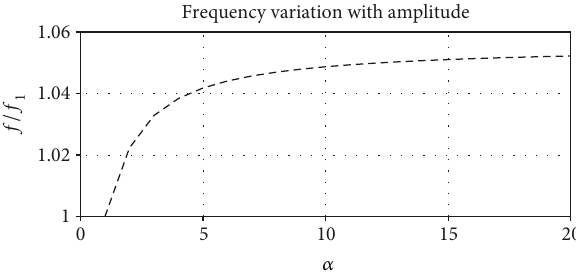
Figure 1: 1 dof system with bilinear spring.